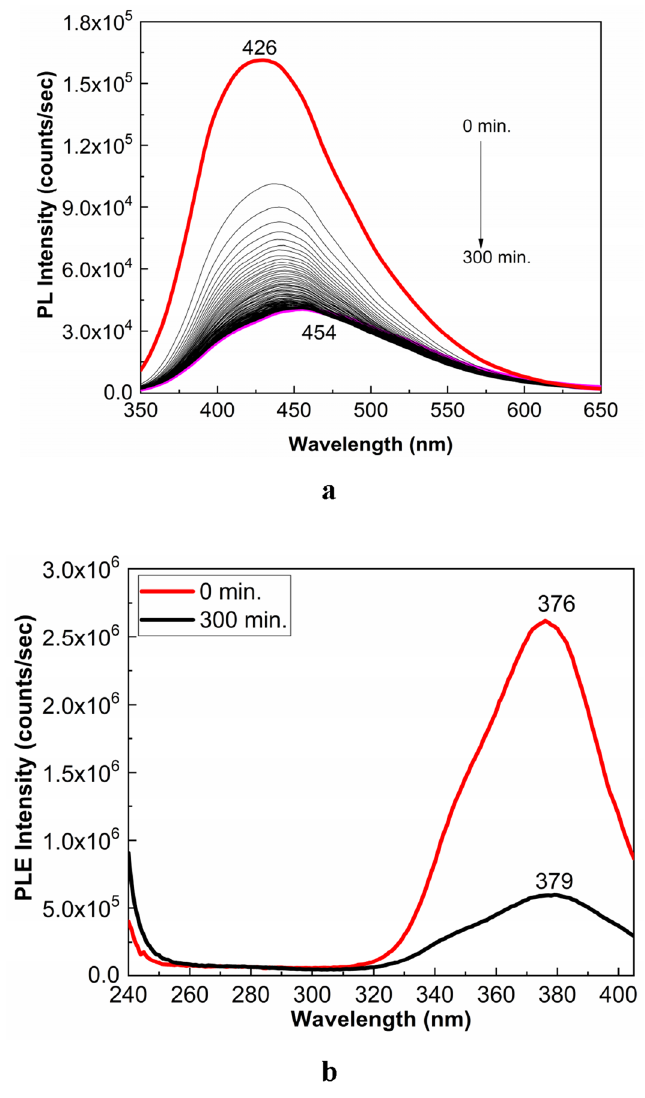
Figure 2. PL ( a ) and PLE ( b ) spectra of the Controloc ( 4 ) drug and their evolution during of 300 min. exposure to UV light. PL and PLE spectra were recorded at the excitation and emission wavelengths of 335 nm and 425 nm, respectively. In Figure ( a ), the red and magenta curves correspond to the PL spectra of the Controloc ( 4 ) drug prior and after 300 min of UV light exposure, while the black curves show PL spectra successively